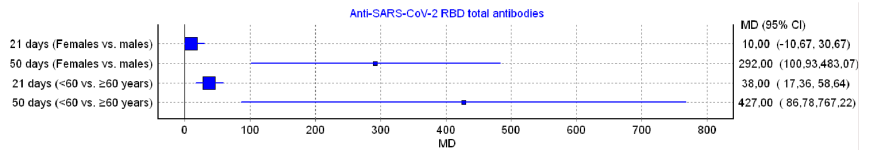
Figure 2. Mean difference (MD) of total anti-SARS-CoV-2 RBD antibodies in seronegative subjects receiving a complete cycle (i.e., two doses) of Pfizer COVID-19 mRNA BNT162b2 vaccine as calculated after 21 and 50 days from the first